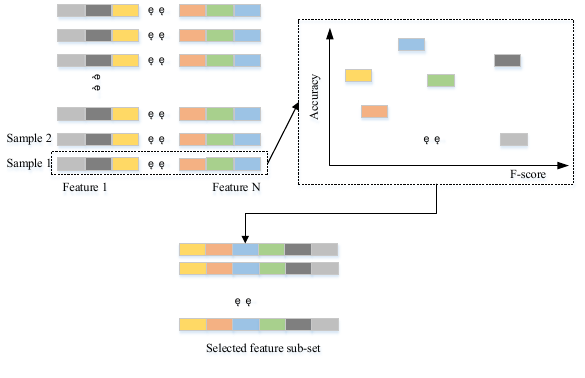
Table 1. Dataset